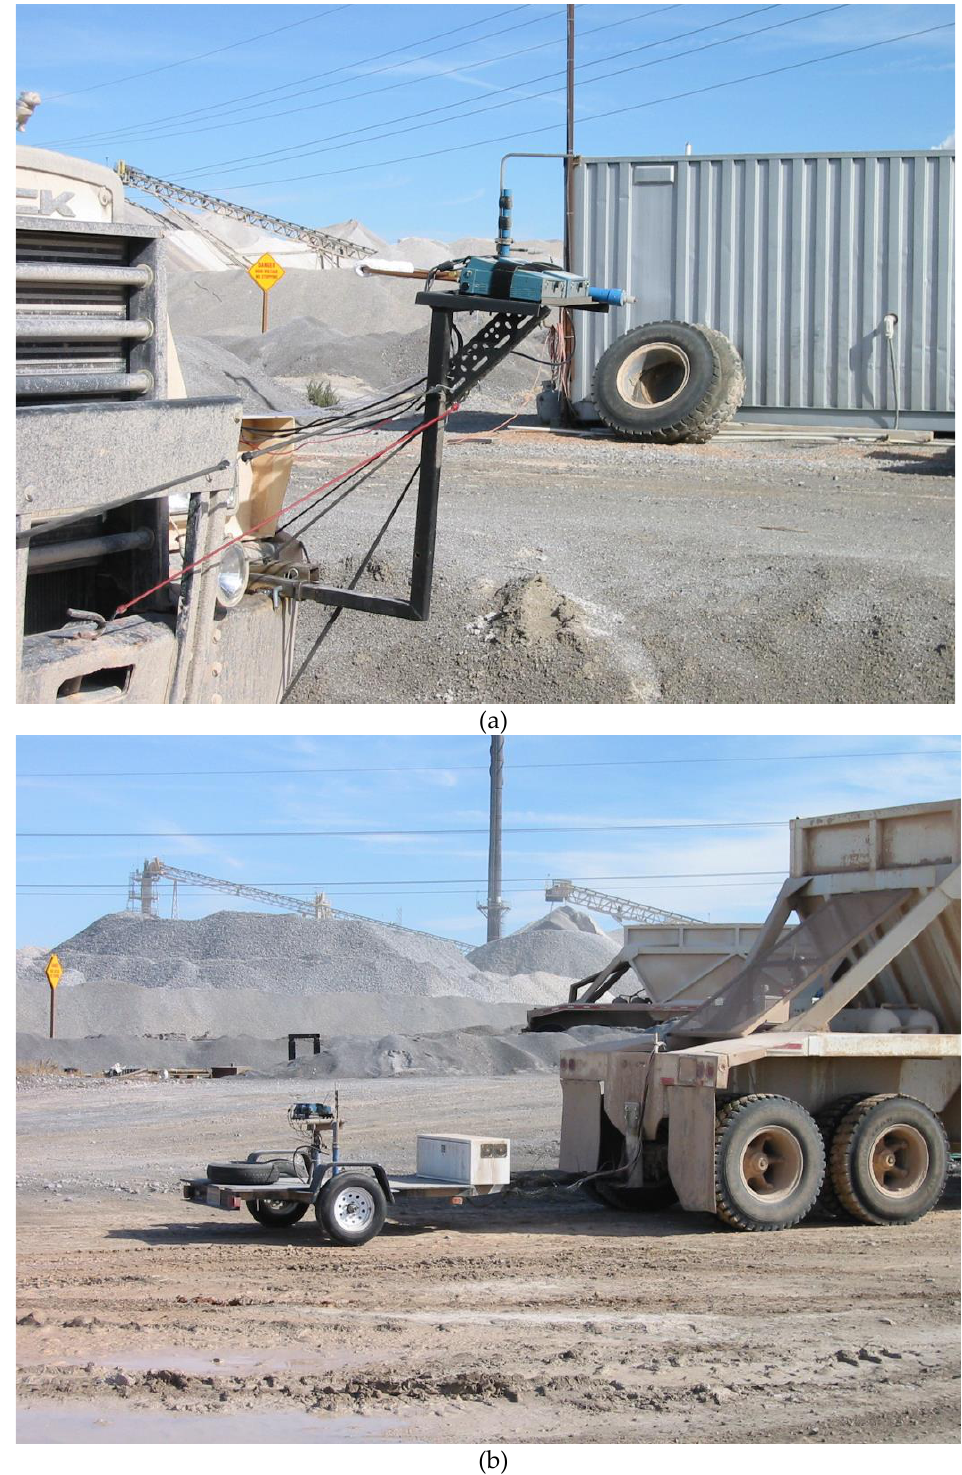
Figure 1. Photographs of the SCAMPER equipment outfitted on the front ( a ) and rear ( b ) of the mine haul